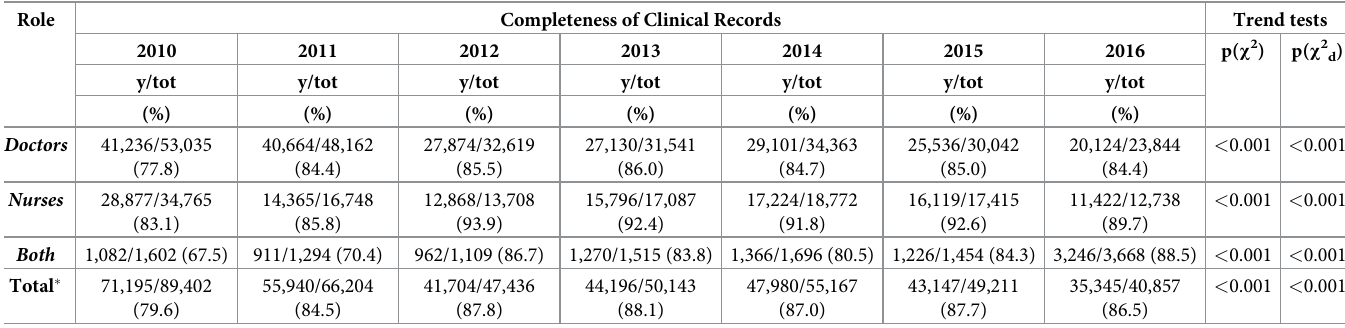
Table 1. Item completeness by professional